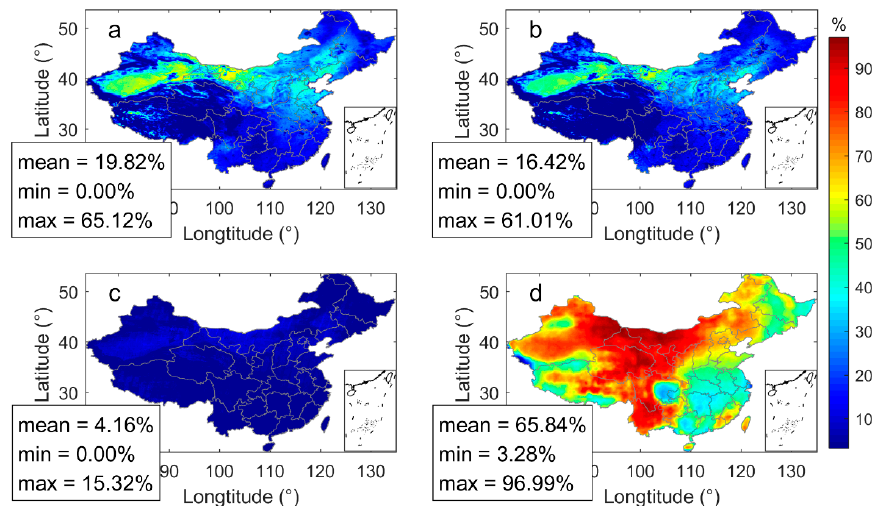
Figure8. Spatialdi ff erencesofpixel-leveltemporalcompletenessfor( a )DBAOD,( b )DT_DB_Combined Figure 8. Spatial differences of pixel-level temporal completeness for ( a ) DB AOD, ( b ) DT_DB_Combined AOD, ( c ) MISR AOD, and ( d ) FRS-EE fused AOD. AOD, ( c ) MISR AOD, and ( d ) FRS-EE fused AOD. Table 3. The average of temporal completeness for original, all source averaged, and FRS-EE fused AODs in di ff erent